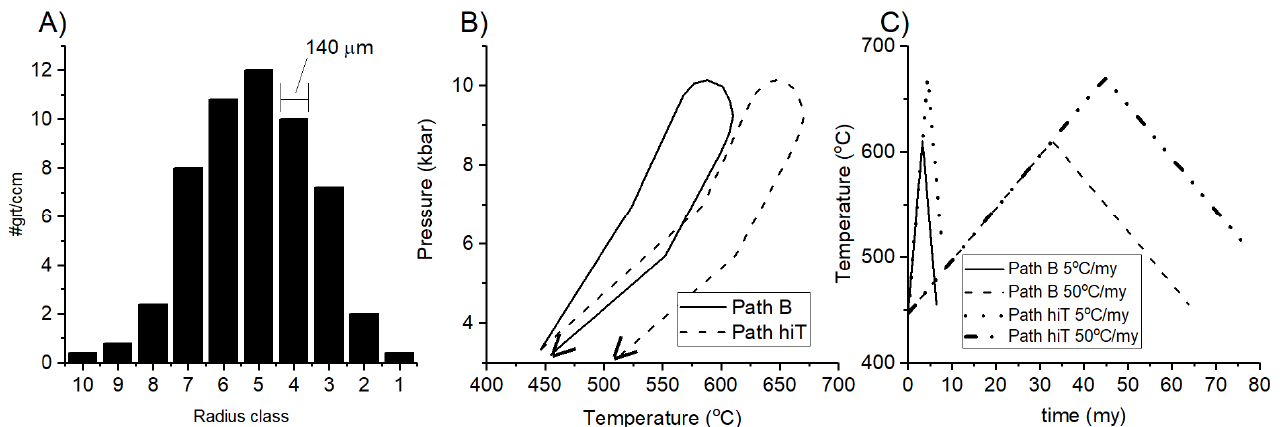
Figure 3. Overview of input specifications used for THERIA_G modeling. ( A ) Garnet crystal size distribution (CSD) for each radius class as used here and by [26]. Each radii class increases in radius by 140 μ m from the previous, with class 10 being the smallest and class 1 being the largest. #grt/ccm = number of garnets per cubic centimeter. ( B ) Specified P-T paths over which the modeled rock evolved. Path B is identical to that used by [26]. Path hiT is a higher temperature analog of path B. ( C ) Temperature-time plot of each of the four model scenarios tested in the study. Both paths in panel b are run at two different heating/cooling rates (5 °C/my and 50 °C/my).